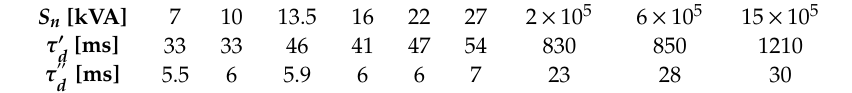
Table 3. The values of electromagnetic time constants for the subtransient and transient states